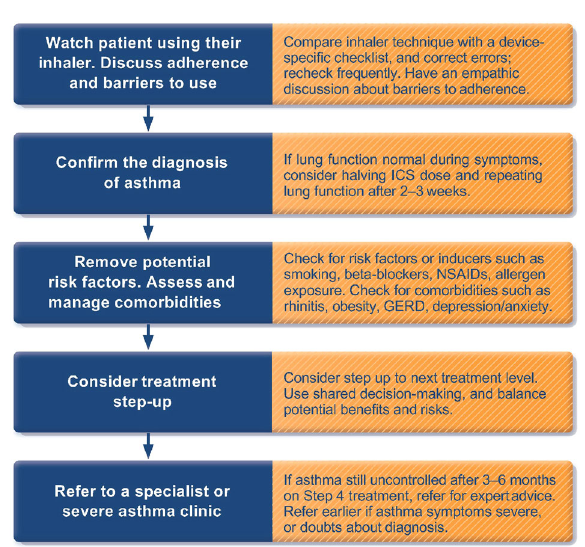
Fig. 2 Investigating poor symptom control and/or exacerbations despite treatment. ICS inhaled corticosteroid, NSAID